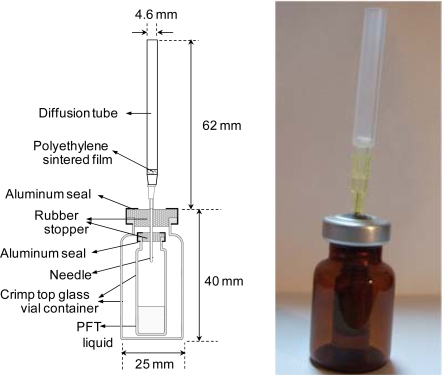
Photograph and schematic diagram of developed PFT doser. To start dosing, the doser has only to be pricked by a needle with a diffusion tube.